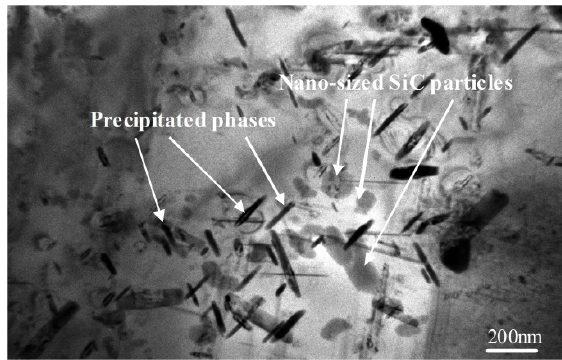
Figure 16. TEM micrograph of the thixoformed part soaked for 10 min at 590 °C with T6.